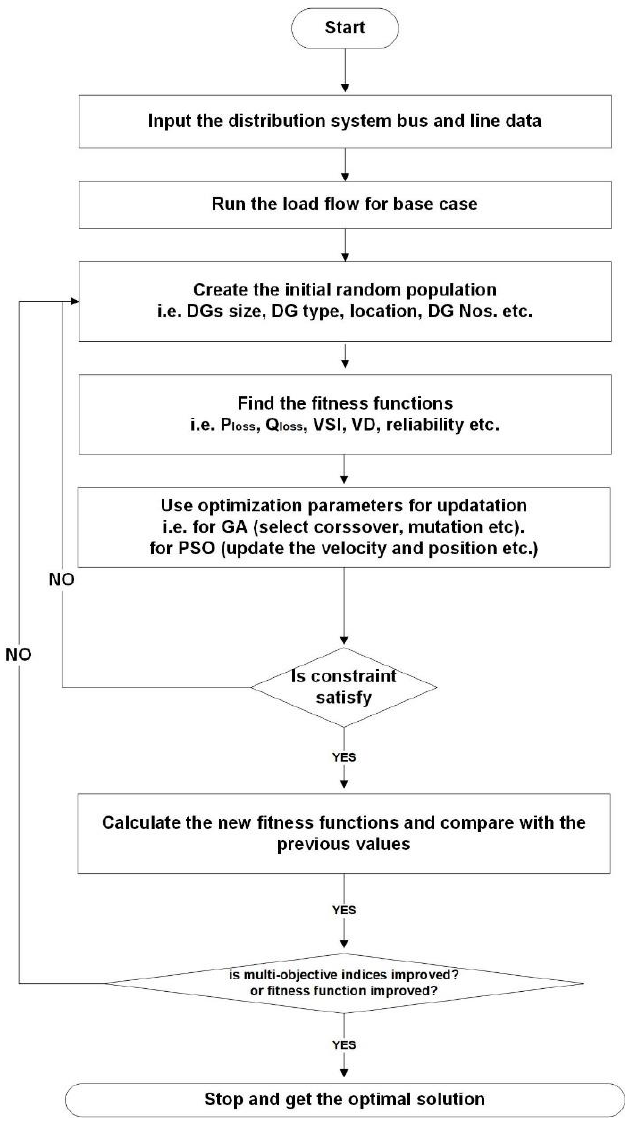
Figure 2. Heuristic algorithm for optimal multi-objective placement and sizing problem.